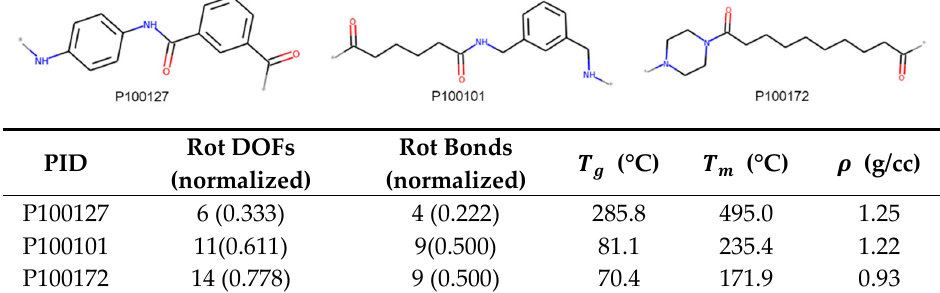
Figure 11. Example of three polyamides, with IDs P100127, P100101, and P100172, whose T g , T m , and ρ can be predicted using trends described in this